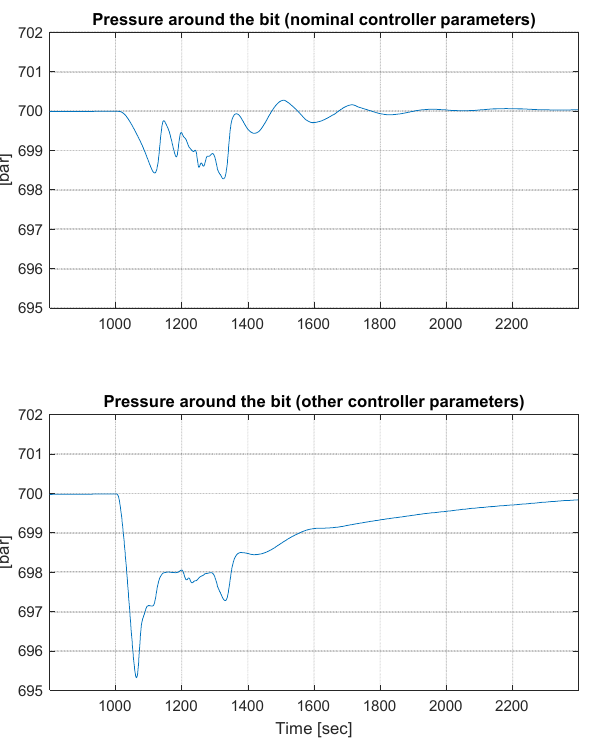
Figure 10: Pressure response using nominal and other (robust) controller parameters.